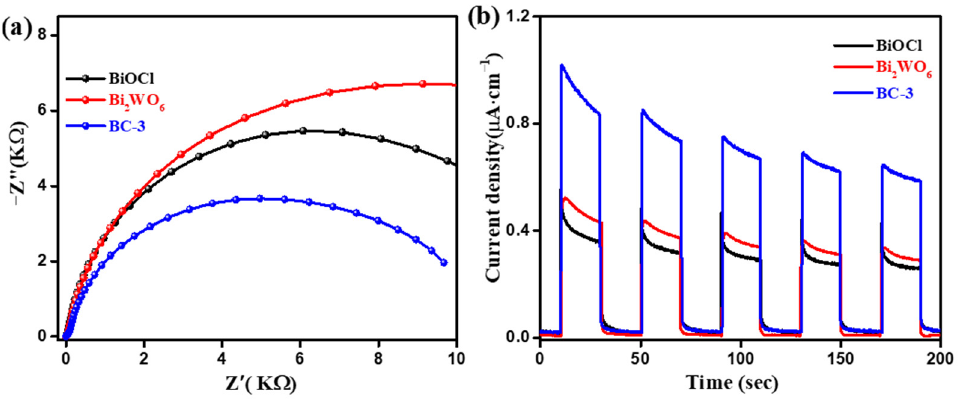
Figure 12. The EIS ( a ) and photocurrent response ( b ) of pure BiOCl, Bi 2 WO 6 , and Bi 2 WO 6 /BiOCl nanocomposites.